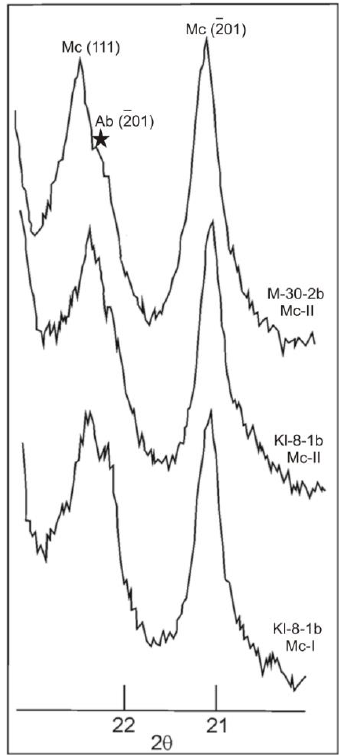
Figure 5. The (201) diffraction of K-feldspars in pegmatites from the Kolmozero field. M-30-2b (Mc-I) represents a K-feldspar from feldspar pegmatites and Kl-8-1b (Mc-I) and Kl-125-1 (Mc-II) originate from albite-spodumene pegmatites. X-ray phase analysis showed that K-feldspars from albite-spodumene and feldspar pegmatites mainly contain a microcline (Mc) and an additional Na phase (Ab).